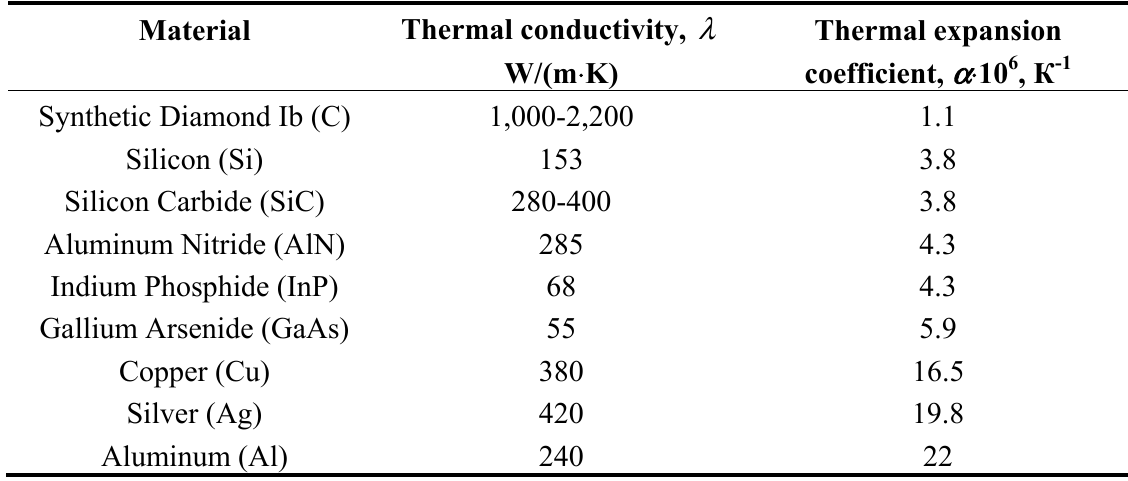
Table 1. Thermal conductivity and thermal expansion coefficients at room temperature of materials most widely employed in heat sink